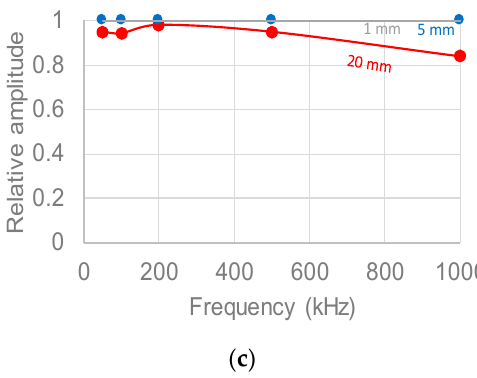
Figure 8. Relative amplitude of the received signal for point (1 mm, in grey), medium (5 mm, in blue), long (20 mm, in red) along the frequency range, from 50 kHz to 1 MHz, and concerning the three source positions: ( a ) surface; ( b ) diagonal; ( c ) vertical.